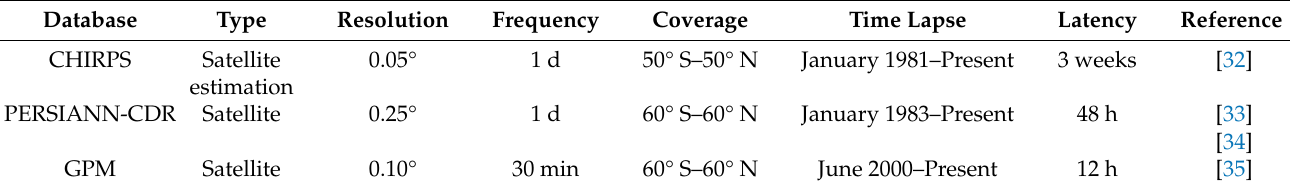
Table 1. Characteristics of the selected (quasi-)global precipitation